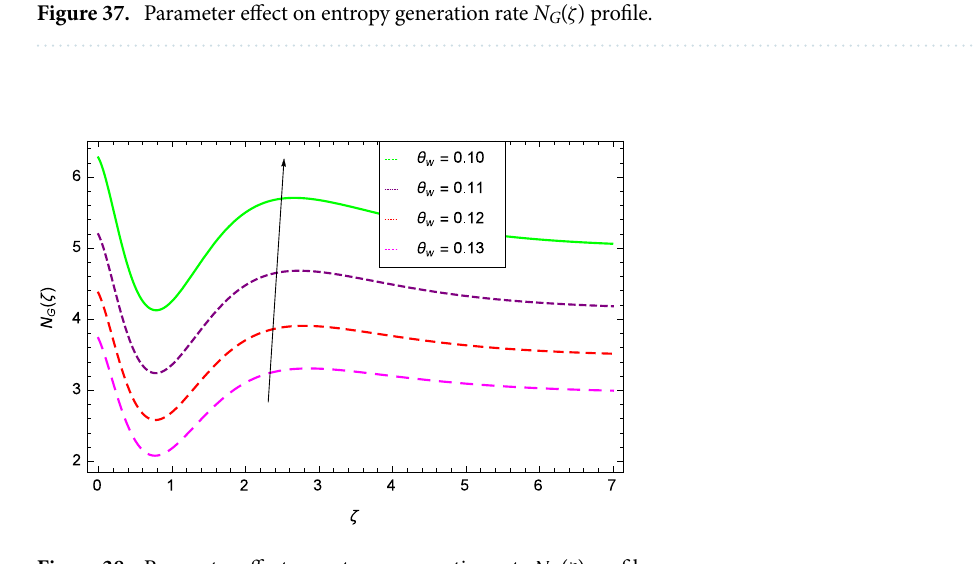
Figure 38. Parameter effect on entropy generation rate N G ( ζ )